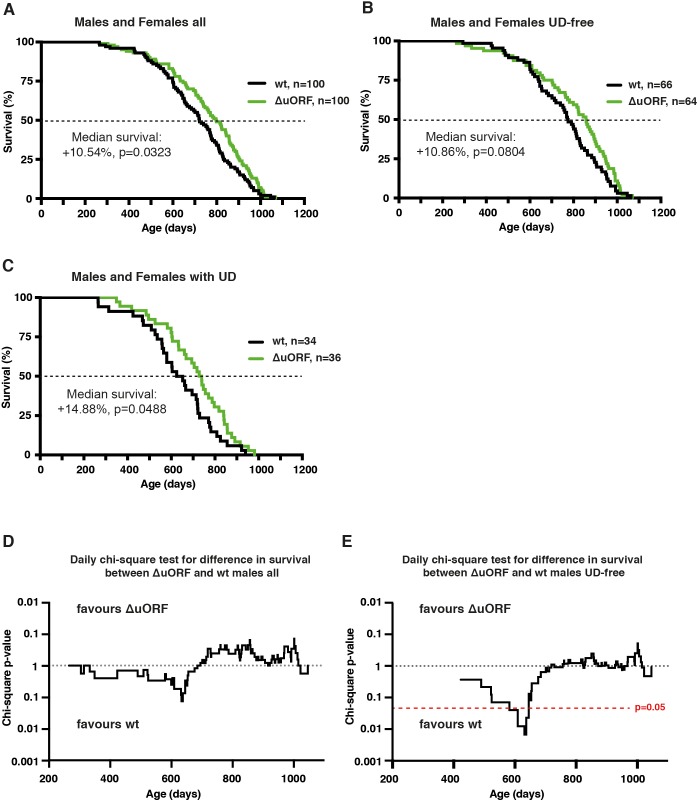
Survival curves of combined male and female cohorts and daily chi-square test for male cohorts.Survival curves of wt and C/EBPβΔuORF mice with females and males combined of (A) the complete cohorts, (B) UD-free mice cohorts and (C) cohorts of mice with UD. For survival curves the increase in median survival (%) of the C/EBPβΔuORF compared to wt mice and statistical significance of the increase in the overall survival as determined by the log-rank test is indicated in the figure. (D,E) Daily chi-square test of differences in survival for C/EBPβΔuORF versus wt male mice of the complete cohort (D) and the UD-free cohort (E). The upper part of the diagrams reflects increased survival of C/EBPβΔuORF males while the lower part reflects increased survival of wt males. The red line indicates the significance threshold (p=0.05).